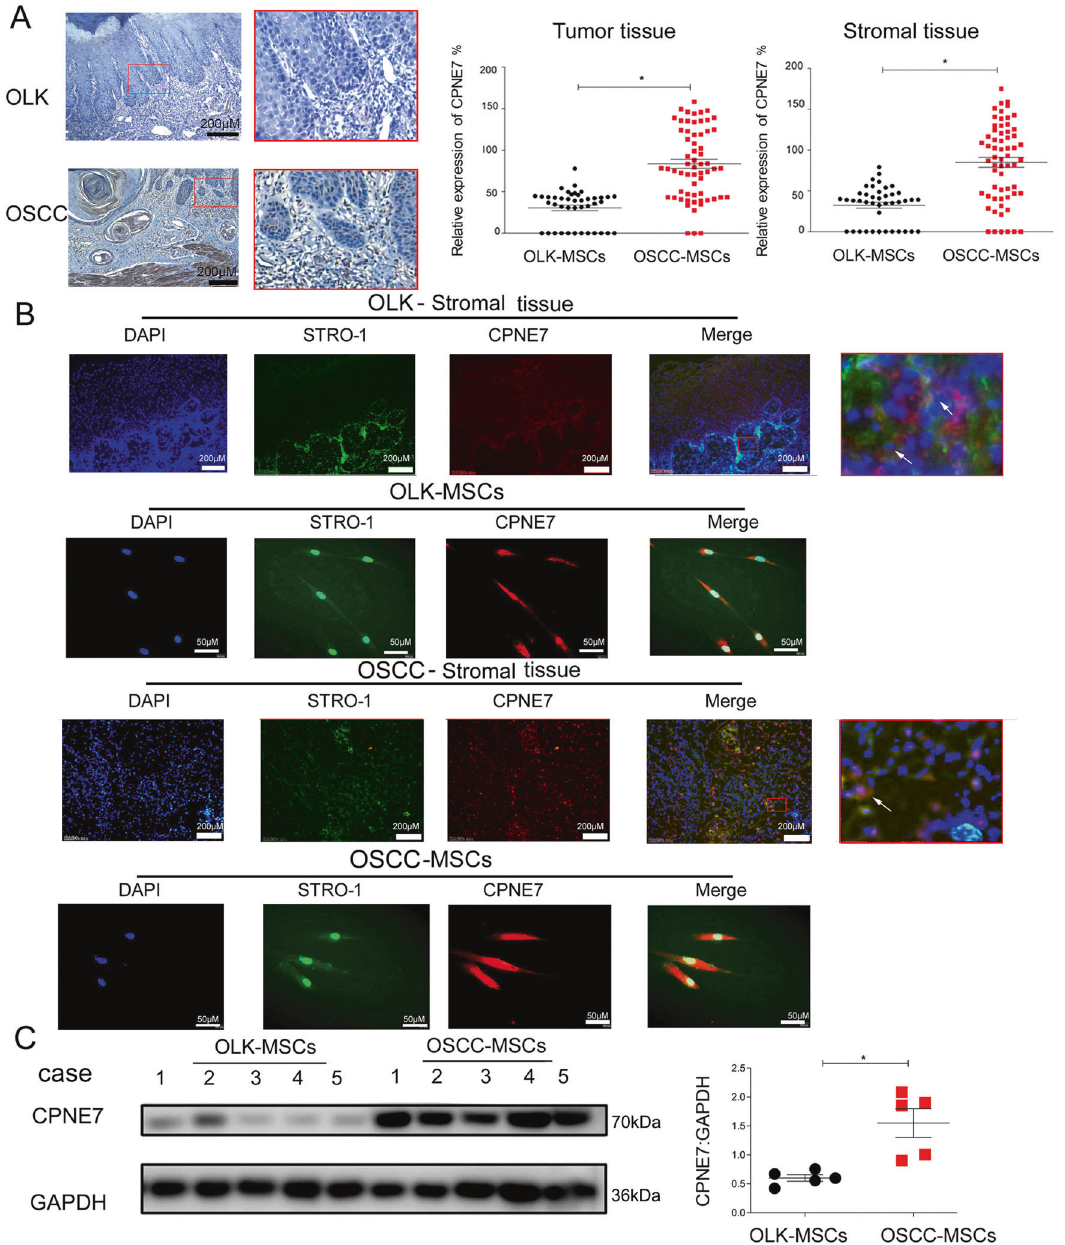
Fig. 4 Higher expression of CPNE7 in tissue and MSCs of OSCC than OLK. A Representative immunohistochemical images of CPNE7 expression levels in OLK and OSCC tissues. B Immuno fl uorescence detection of the expression of CPNE7 and the MSC marker STRO-1 in tissue and MSCs. The arrow indicated the co-expression of CPNE and STRO-1 in the same cell of tissue. C Western blotting was performed to detect the expression of CPNE7 between OLK-MSCs and OSCC-MSCs ( n = 5). The tests were repeated three times. Data were expressed as means ± SD. * p <